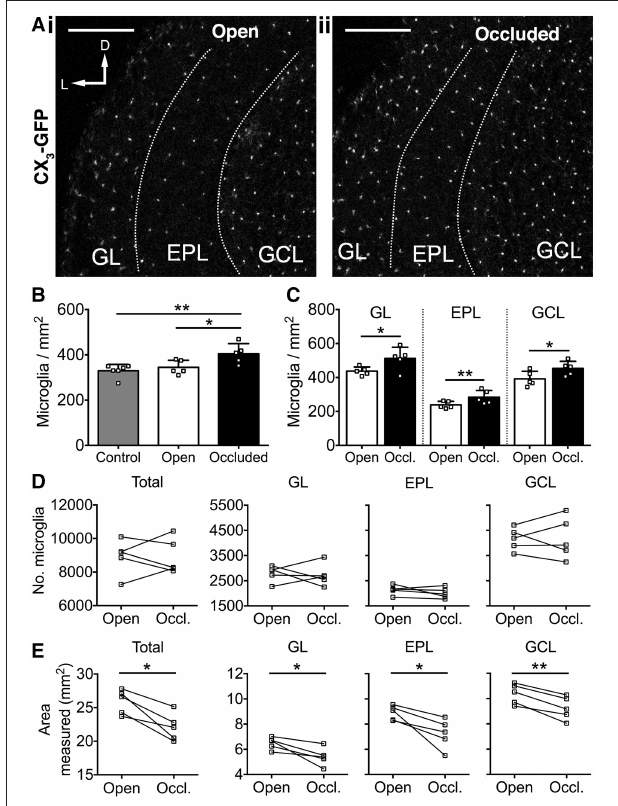
FIGURE 3 | Activity-dependent increase in microglial density after 7 days of naris occlusion. (A) Microglia in (i) open and (ii) occluded OBs. Scale bars: 200 µ m. (B) Higher microglial density in occluded OB than open ( * p = 0.042) or control ( ** p = 0.009) OBs; no difference between open and control OBs ( p = 0.76) [one-way ANOVA with Tukey’s test; p = 0.009, F (2 , 13) = 6.914]. ( C) Higher microglial density in glomerular (GL; * p = 0.048, t = 2.83), external plexiform (EPL; ** p = 0.009, t = 4.78), and granule cell (GCL; * p = 0.011, t = 4.53; paired t -tests) layers of occluded OBs. B,C: n = 6 pooled pairs of OBs from 6 control mice and 5 pairs of open and occluded OBs from 5 naris-occluded mice. (D) No difference in number of microglia between open and occluded OBs in total ( p = 0.97, t = 0.03) or for the GL ( p = 0.79, t = 0.28), EPL ( p = 0.28, t = 1.24), or GCL ( p = 0.91, t = 0.11; paired t -tests). (E) Decreased total OB area ( * p = 0.011, * p = 0.030, * p = 0.027, ** p = 0.003, t = 4.54), GL area ( p = 0.030, t = 3.31), EPL area ( p = 0.027, t = 3.39) and GCL area ( p = 0.003, t = 6.59; paired t -tests) in occluded vs. open OBs. (D,E) : n = 5 pairs of open and occluded OBs from 5 naris-occluded